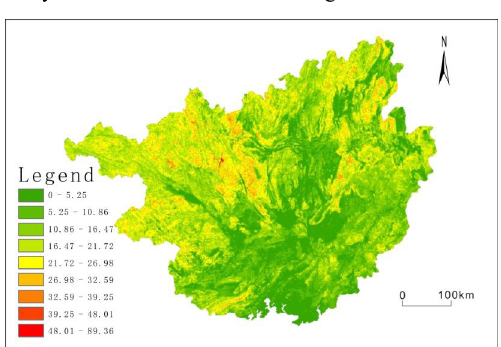
Figure 4. Guangxi slope analysis diagram